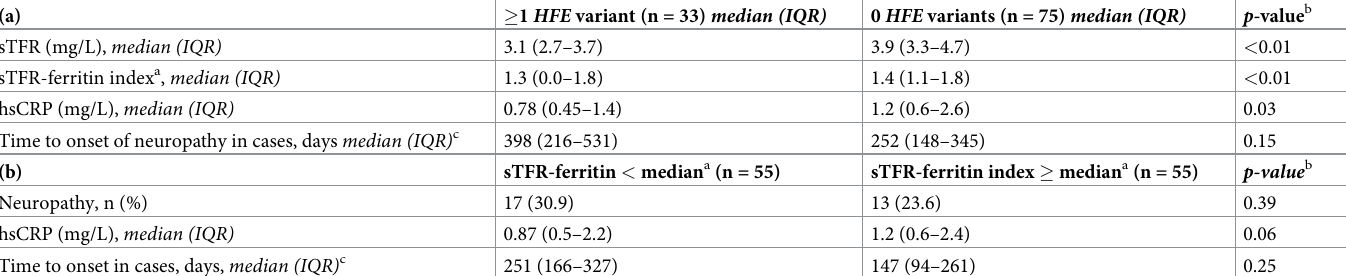
Table 2. Unadjusted analyses of baseline iron status, inflammation, and rapidity of onset of neuropathy in ACTG Study 384 participants with HFE genotype and/or serum iron indices. (a) � 1 HFE variant (n = 33) median